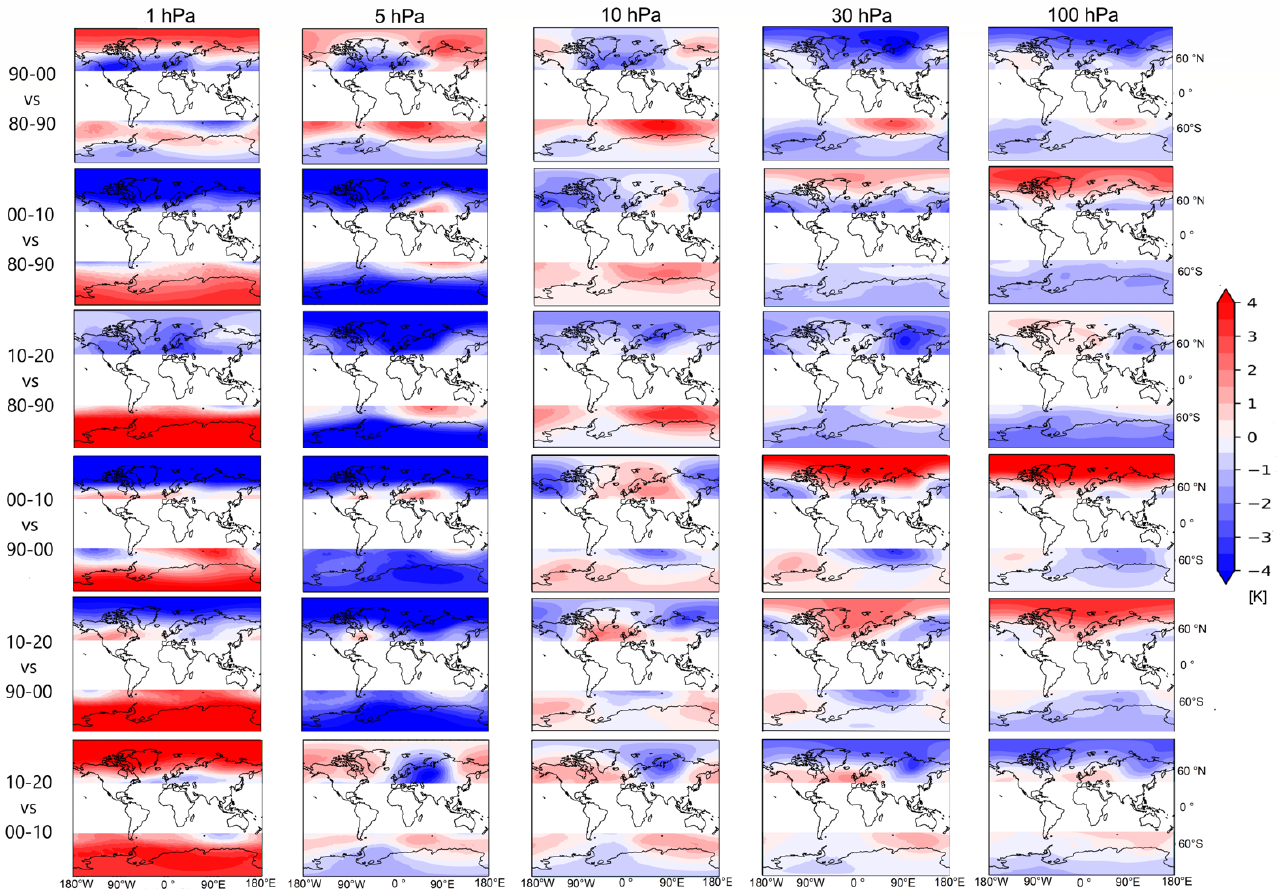
Figure 3. Difference of temperature climatology (K) between decades for 1, 5, 10, 30 and 100 hPa using ERA5 reanalysis.